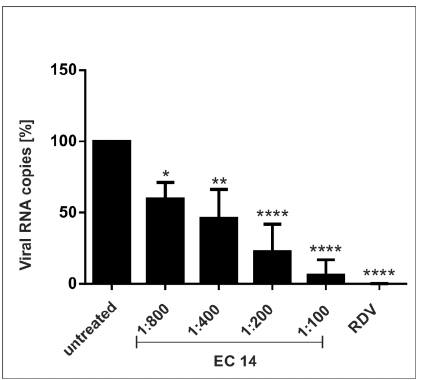
Figure 5. European black elderberry dried powder (EC 14) resolved in water inhibits replication of SARS-CoV-2 Wuhan type. Calu-3 cells were infected with the clinical isolate SARS-CoV-2 PR-1 at a MOI of 2 × 10 − 2 . One hour after infection and removal of input virus, cells were treated with indicated dilution steps of EC 14. A total of 1 µ M RDV was included as a positive control. Cell